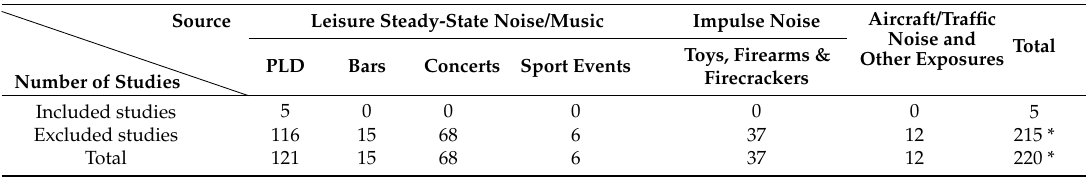
Table 3. Statistics of included and excluded